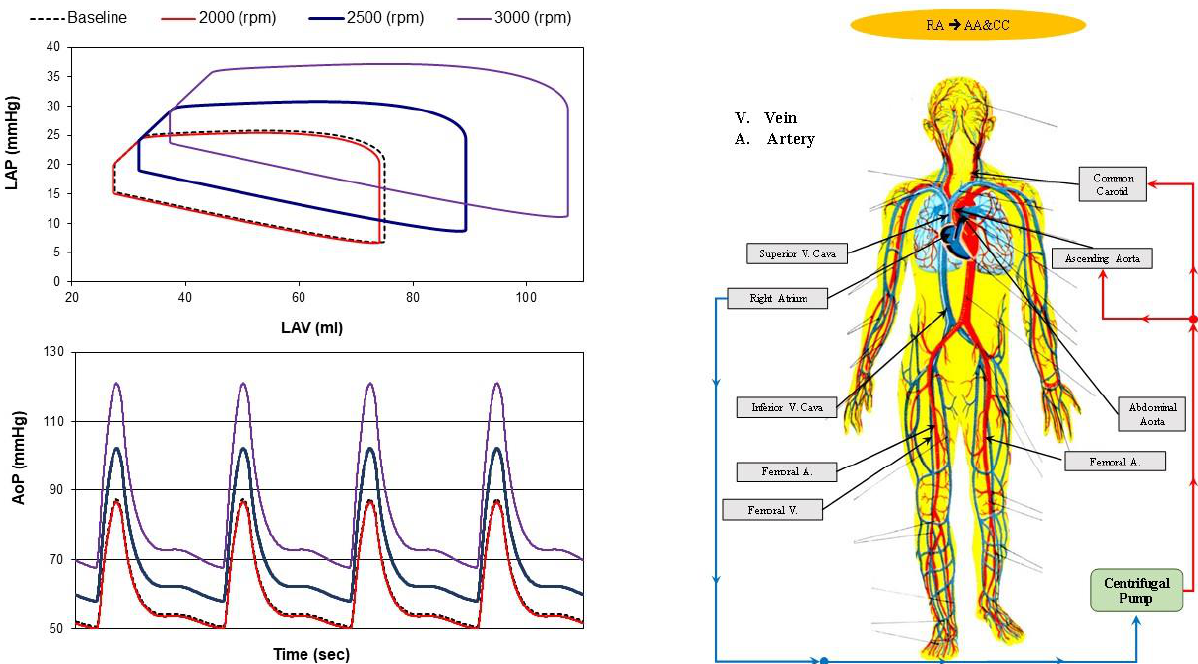
Figure 7. Left atrial pressure–volume loops ( top-left panel ) and instantaneous AoP waveforms ( bottom-left panel ) obtained in baseline conditions (black dashed line) and with RA → AA&CC cannulation when the pump rotational speed was set to 2000 (red line), 2500 (blue line) and 3000 (lilac line) rpm. The ventricular loops and the instantaneous waveforms obtained using CARDIOSIM© were stored in excel files and subsequently plotted. In RA → AA&CC cannulation ( right panel ) the centrifugal pump draws blood from the right atrium and ejects it into the ascending aorta and common carotid artery bilaterally.